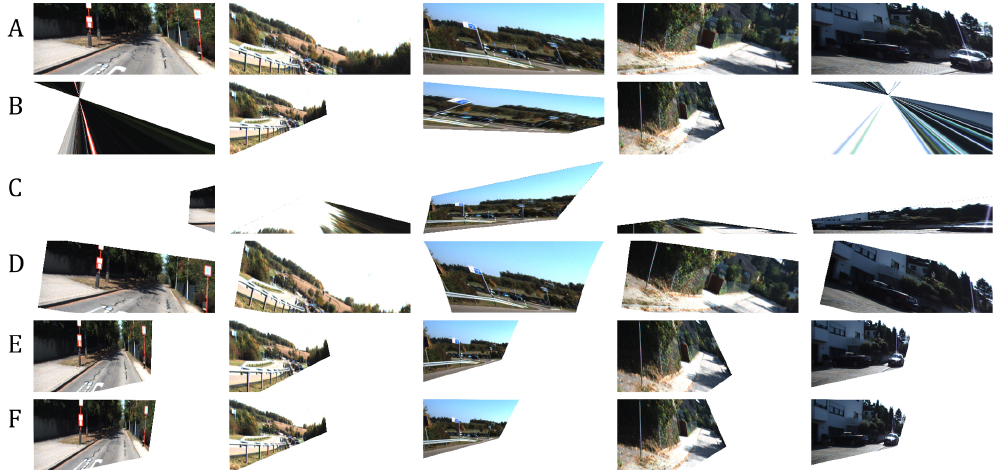
Figure 8. More results using unseen data from KITTI. ( A ): Distorted input images. ( B ): Corrected image using homography estimation ( C ): Corrected image using the technique of Chaudhury et al. [21]. ( D ): Corrected image using the technique of Li et al. [11]. ( E ): Corrected image using our method. ( F ): Ground-truth. Our network can correct an extremely distorted image.